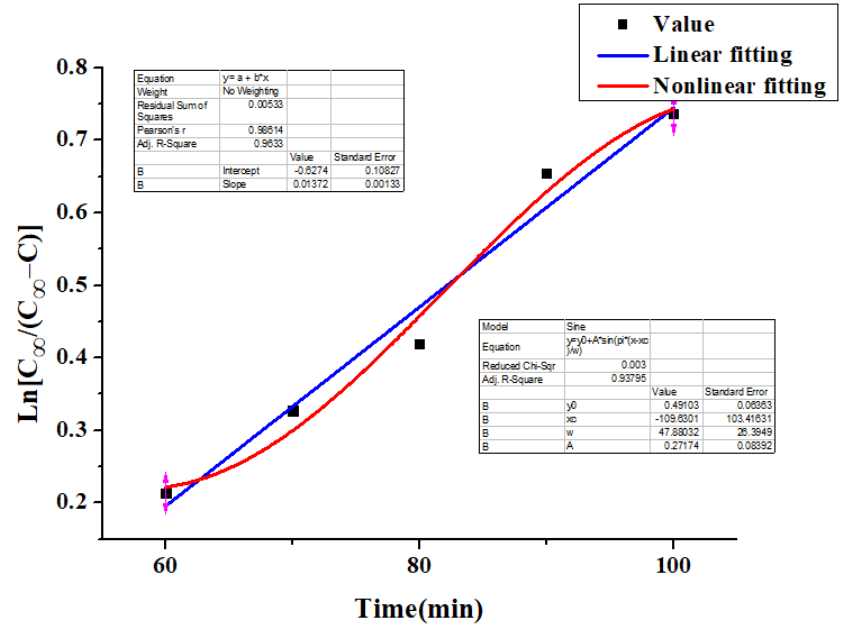
Figure 12. The relationship between ln [ C ∞ /( C ∞ − C )] and time.